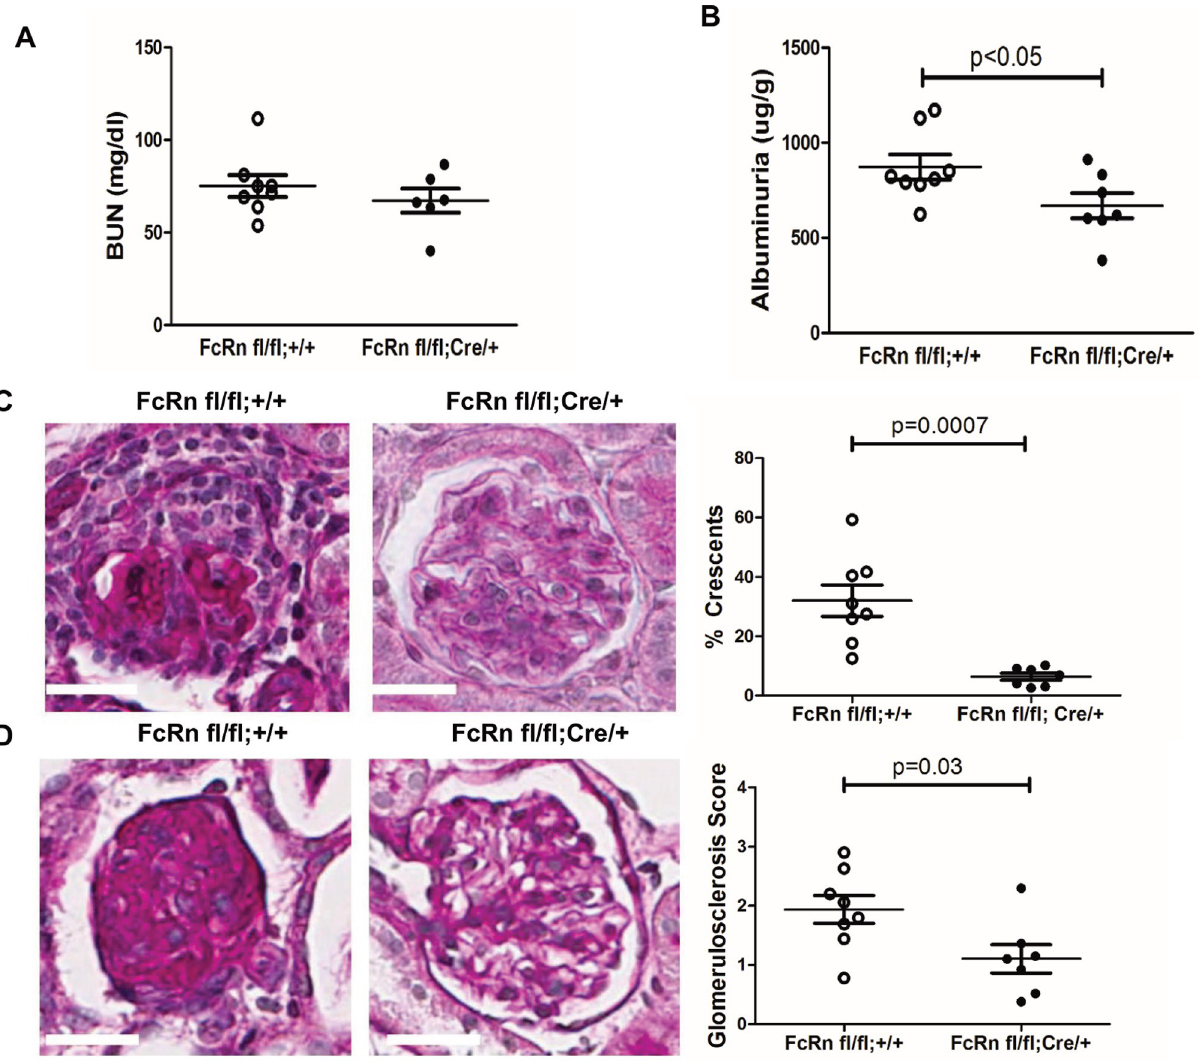
Fig 5. Podocyte specific KO of FcRn results in a significant decrease in albuminuria, glomerulosclerosis, and glomerular crescents after nephrotoxic serum nephritis induction. A , Urine albumin to creatinine ratios in control were significantly higher than podFcRn KO mice (n = 8 control and n = 7 podFcRnKO mice), p = 0.0480. B , BUN in control and podFcRn KO mice were similar (n = 8 control and n = 6 podFcRnKO mice), p = 0.3897. C , Left panel: representative images of histology in control mice at day 28. Middle panel: representative image of histology in podFcRn KO at day 28. Scale bar 20 μ m. Right panel: Glomerulosclerosis score in control and podFcRn KO mice (n = 8 control and n = 7 podFcRnKO mice per group). Podcyte-specific KO of FcRn results in significant decrease in glomerulosclerosis score compared to control mice (p = 0.03). D , Left panel: representative images of crescents in control mice. Middle Panel: representative images of crescents podFcRn KO mice shown. Scale bar 20 μ m. Right panel: Percentage of crescents in control and podFcRn KO mice (numbers of mice are same as in C). Podocyte-specific KO of FcRn results in a significant decrease in the number of crescents (p =